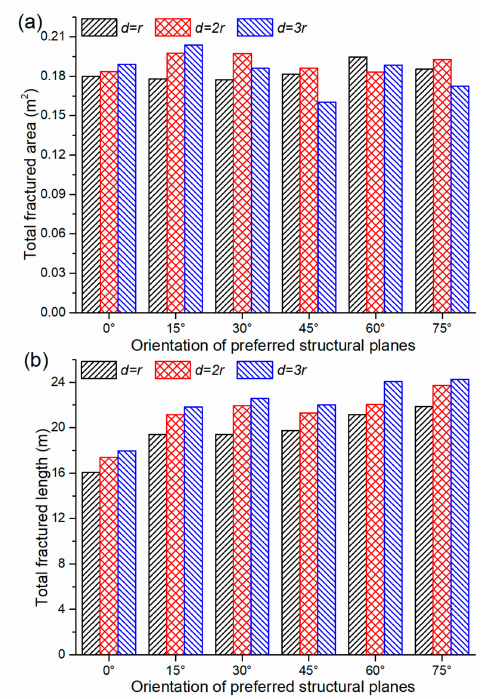
Figure 14. Total fractured area ( a ) and total length of fractures ( b ) for di ff erent spacings. The boundary stress and injection rate were consistent with the base model.